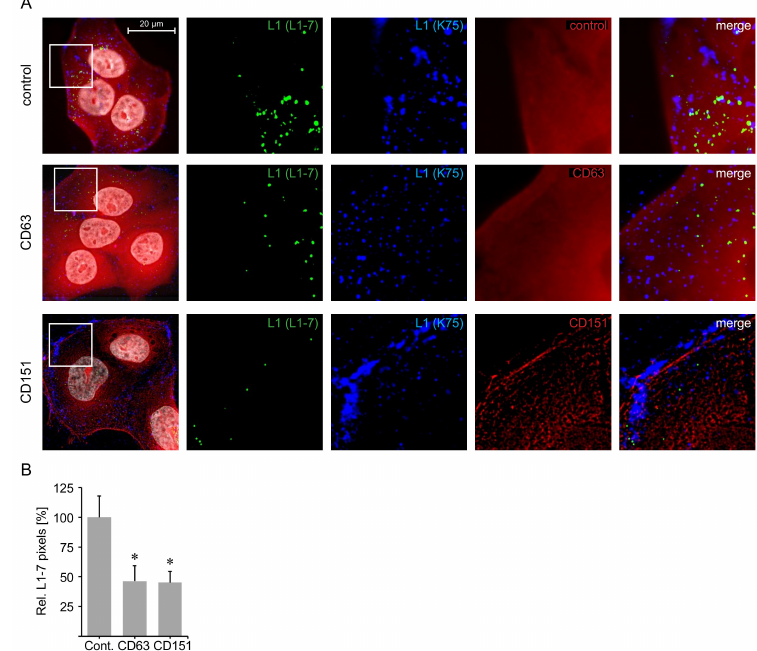
Figure 7. C-terminal peptides of CD63 and CD151 inhibit HPV16 entry. HaCaT cells were transfected with 2 µ M of control peptide or peptides comprising the cytoplasmic C-terminal tail of tetraspanin CD63 or CD151, mixed with PULSin transfection reagent 1 h prior addition to the cells. Afterwards, the cells were incubated with HPV16 PsVs for 7 h and stained by immunofluorescence. ( A ) Representative pictures of immunofluorescence with HPV16 L1 monoclonal antibody L1-7 (green), polyclonal antibody K75 (blue), specified peptide (red) and Hoechst for DNA staining (white). L1-7 recognizes the HPV16 L1-7 epitope accessible after HPV internalization and capsid disassembly. K75 recognizes all bound and internalized HPV particles. ( B ) Quantification of relative L1-7 per DNA pixels. Data is shown as mean ± SEM and was normalized to the mean of control peptide (Cont.) transfected cells (set to 100%). Analysis was performed on 20 images per group using ImageJ software. Asterisks indicate significant differences compared to control ( p <